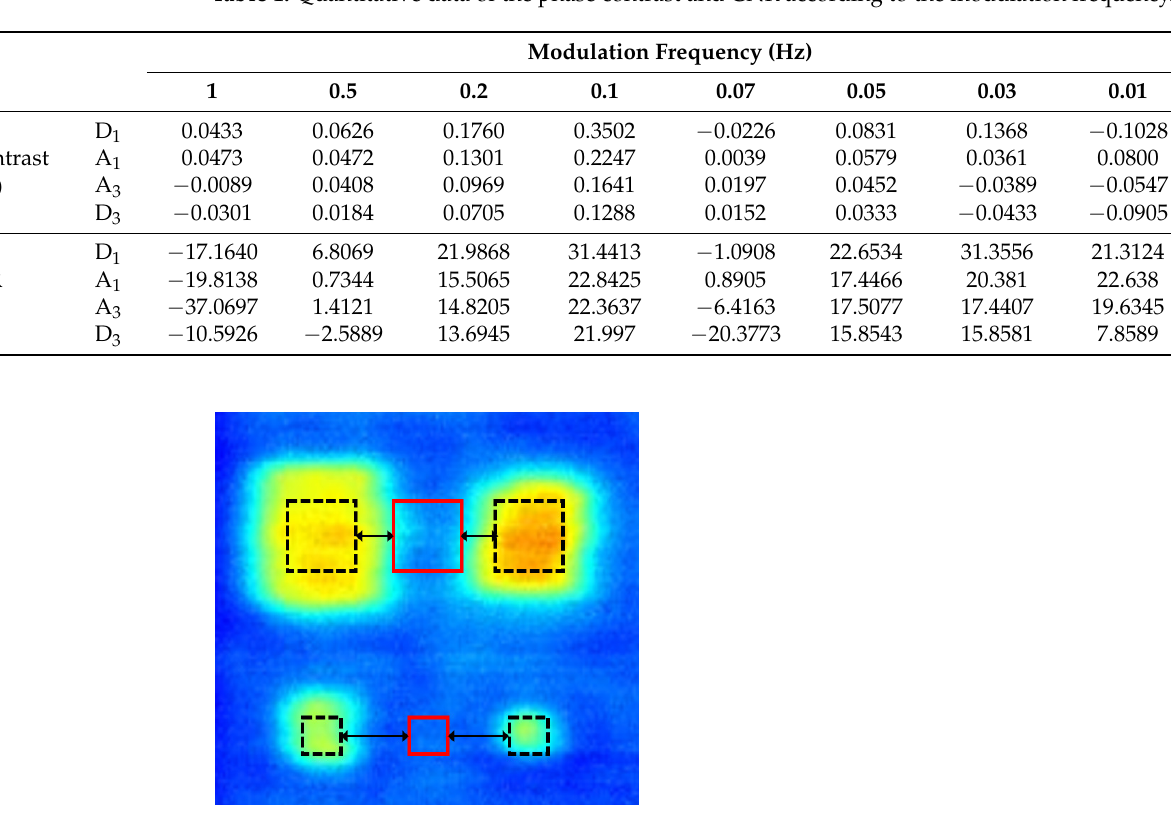
Table 1. Quantitative data of the phase contrast and CNR according to the modulation frequency.